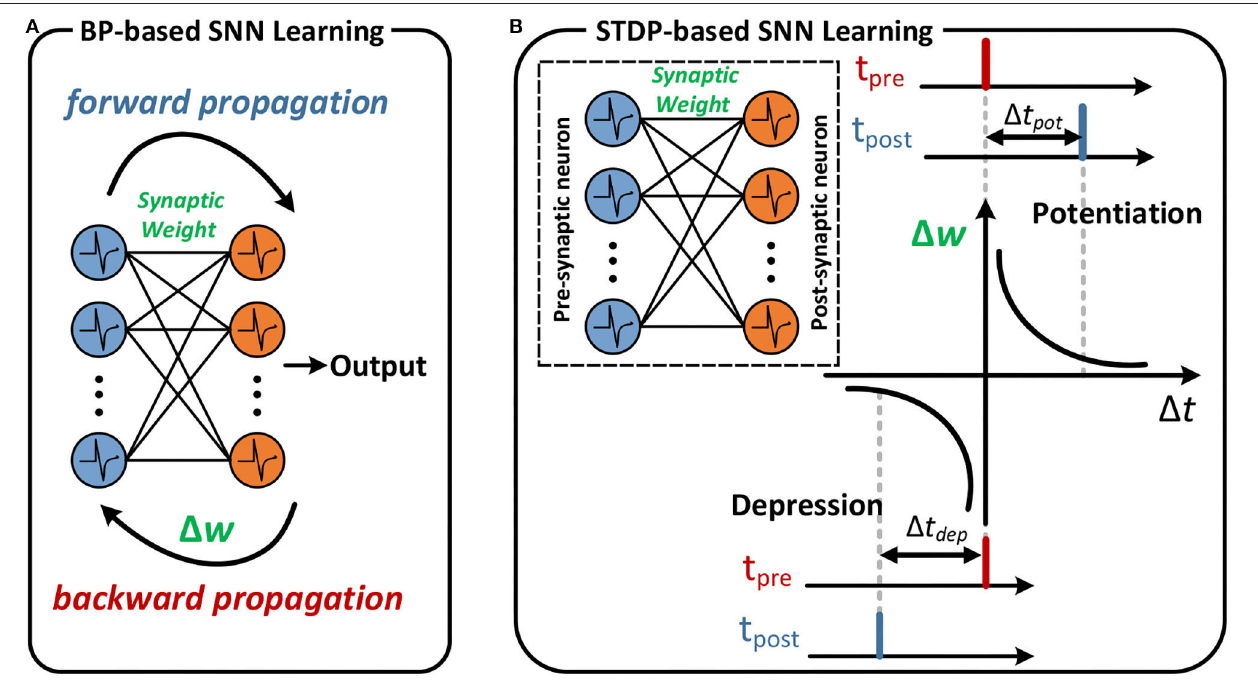
FIGURE 1 | An example of BP-based learning and STDP-based learning. (A) Forward and backward propagation of the SNN. (B) If the post-synaptic neuron fires after the pre-synaptic spike arrives, the synaptic weight between pre- and post-synaptic neuron increases. The magnitude of change increases in proportion to 1 t pot . The reverse order leads to a decrease in synaptic weight in proportion to 1 t dep